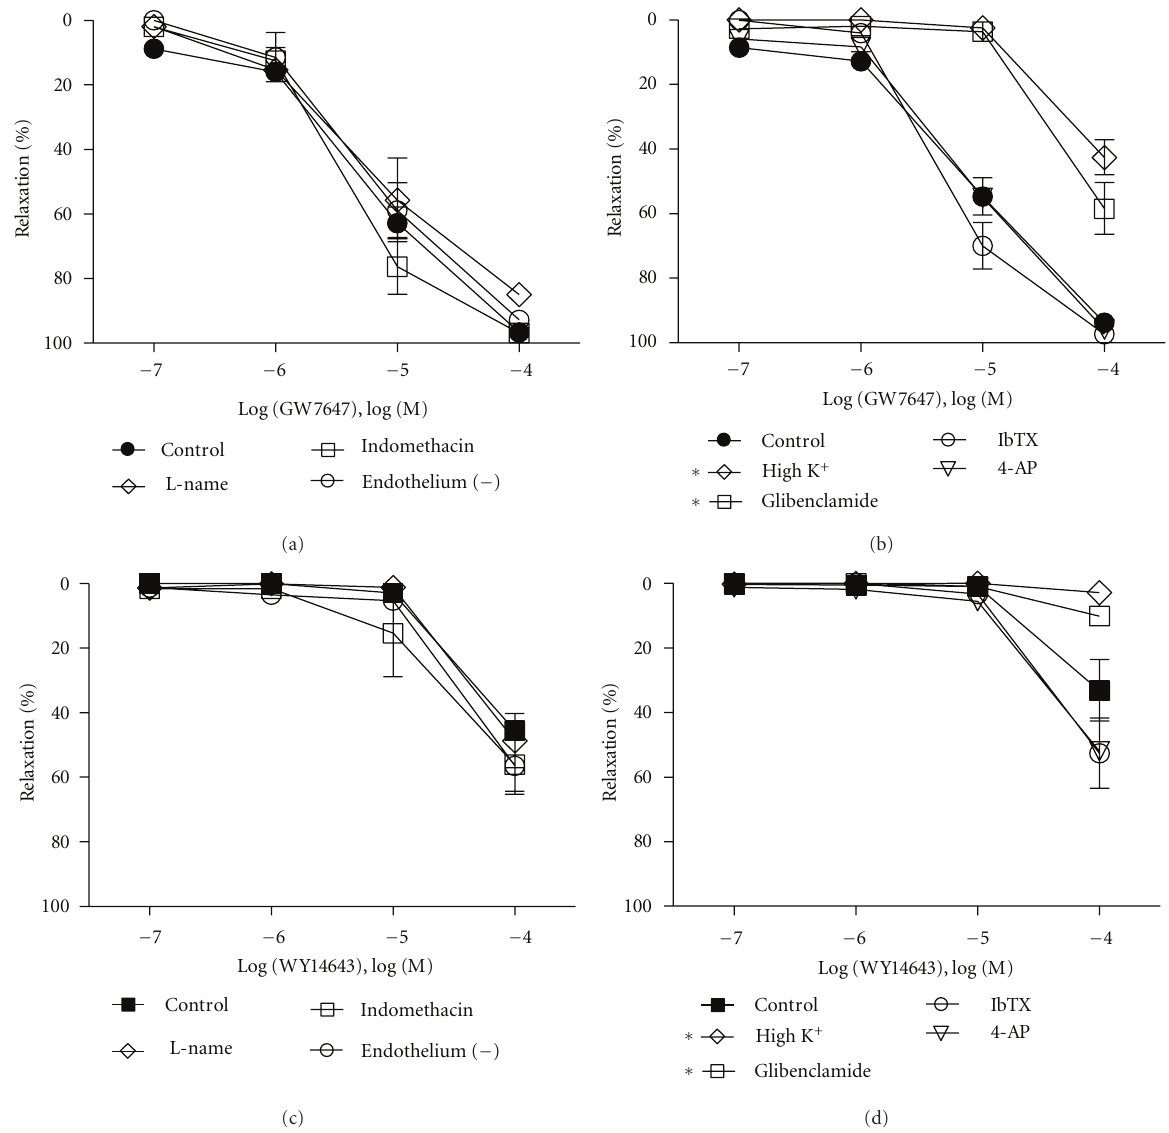
Figure 3: Role of endothelium and K + channels in PPAR α agonist-mediated relaxations. The e ff ects of nitric oxide synthase, cyclooxygenase, and endothelial denudation on the relaxant response of GW7647 (a) and WY14643 (c) in WT mice aortic rings ( n = 3–5). L-NAME or indomethacin or endothelial denudation had no e ff ect on GW7647- and WY14643-mediated aortic relaxations. Responses to GW7647 (b) and WY14643 (d) after pretreatment of aortic rings with elevated external KCI (80 mM), 10 − 7 M Iberiotoxin (IbTX), 3 × 10 − 3 M 4- aminopyridine (4-AP), 10 − 5 M glibenclamide ( n = 3–6). Elevated KCI as well as glibenclamide resulted in attenuation of both GW7647- and WY14643-mediated relaxations. The other K + channel inhibitors did not, however, alter the relaxations to PPAR α agonists. Data are means ± SEM. ∗ Indicates P ≤